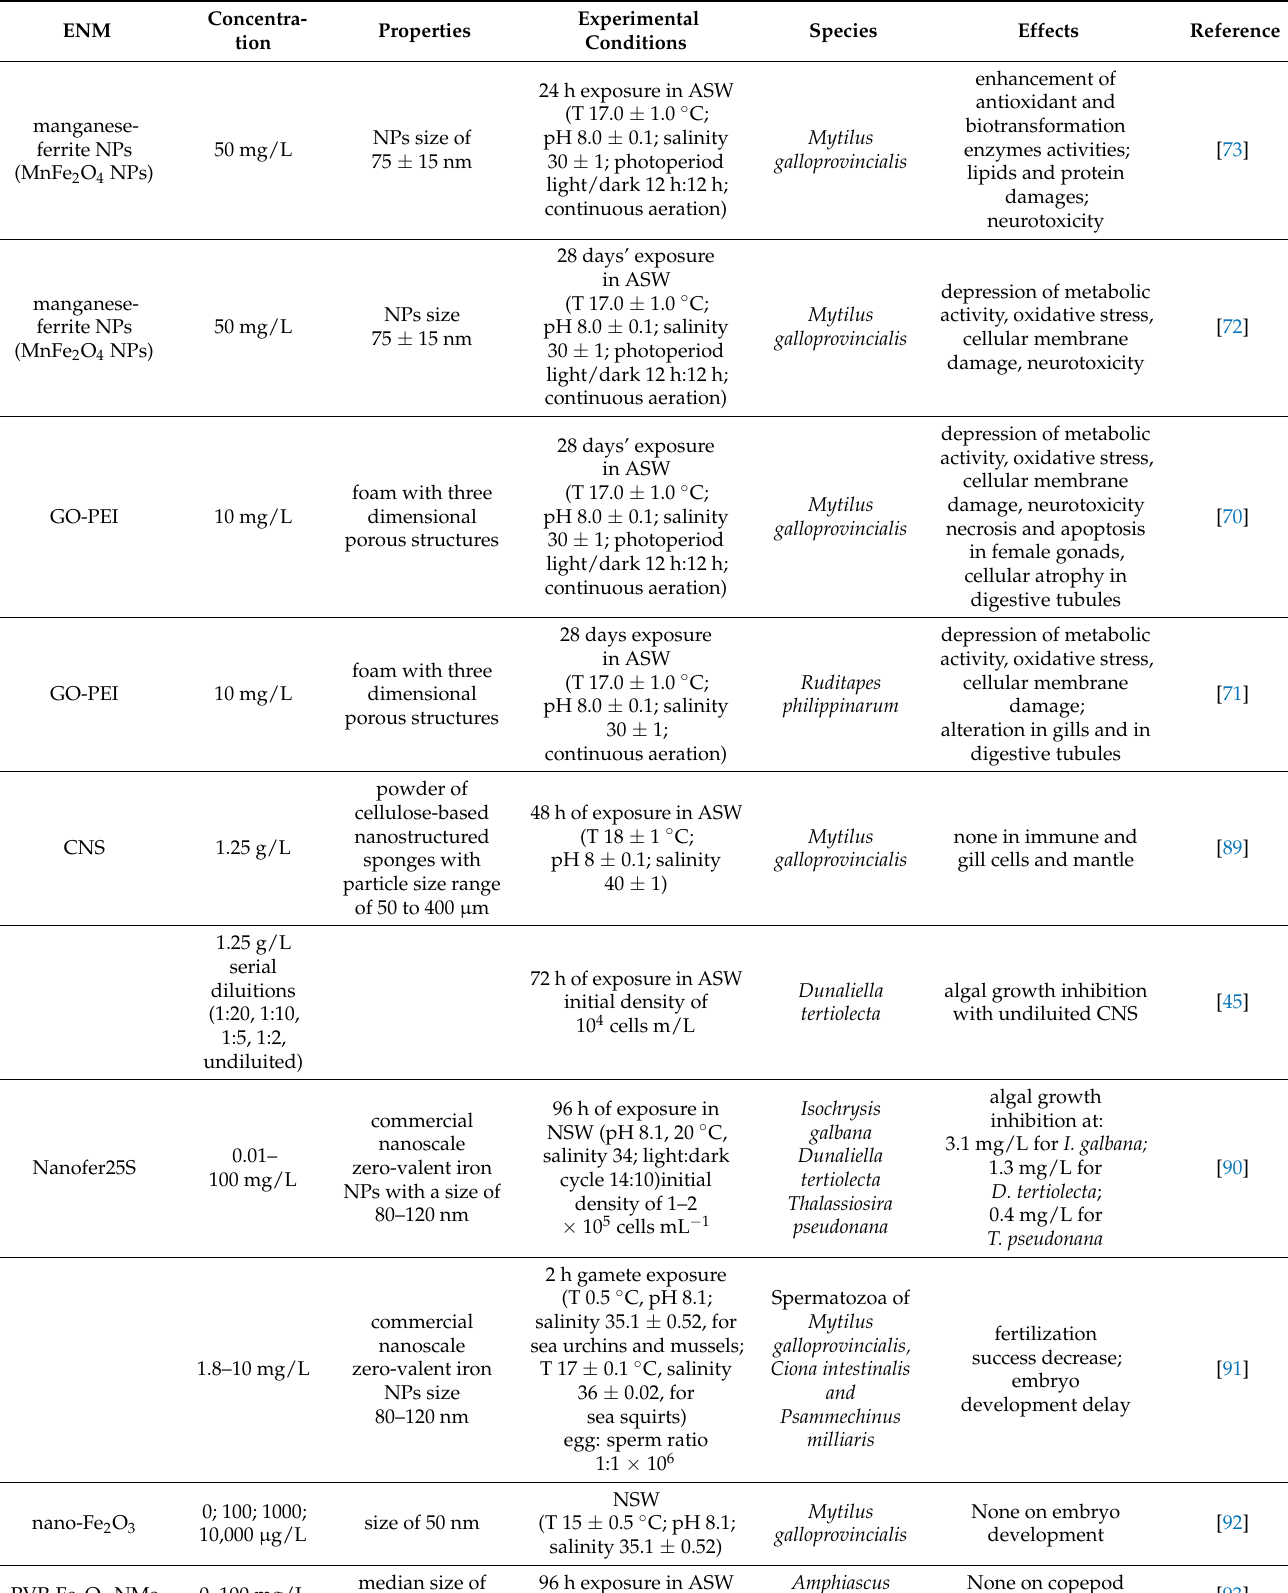
Table 2. Ecotoxicological assessment of ENMs synthetized for the remediation of marine environment. Concentra- ENM